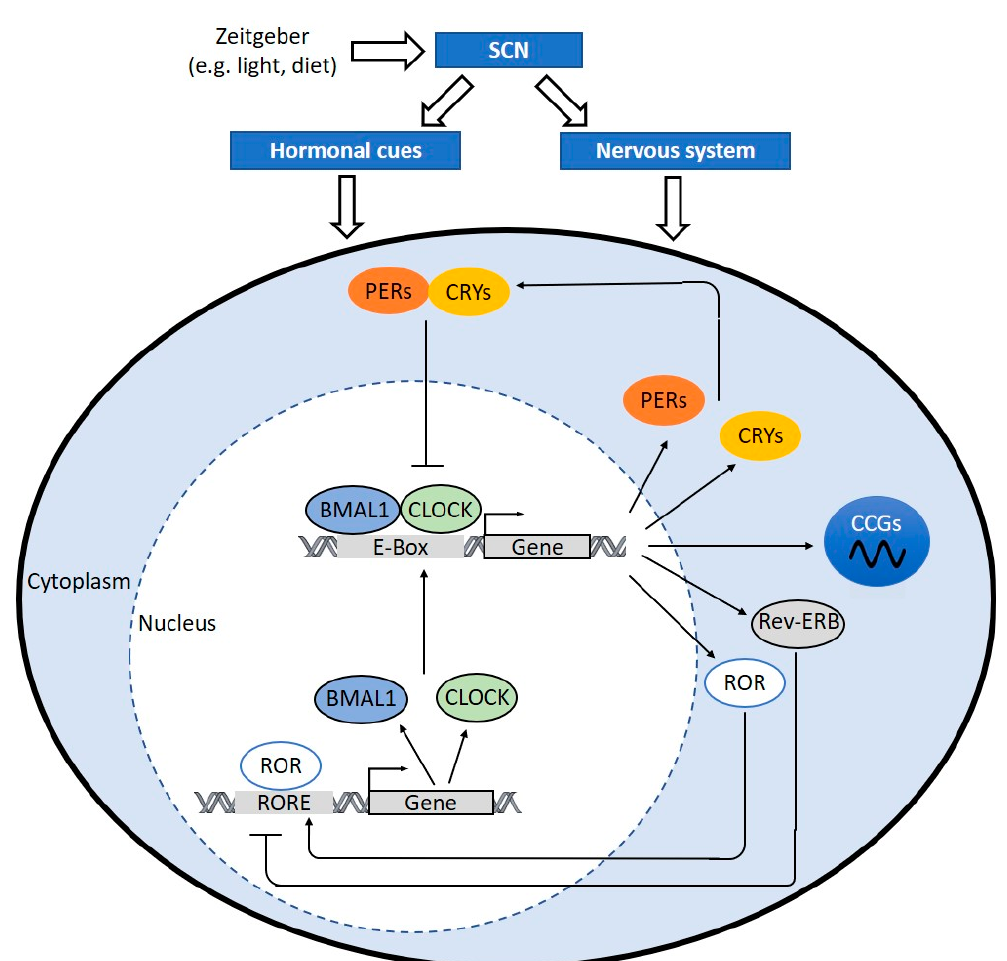
Figure 2. The molecular clock mechanism. When the hypothalamic suprachiasmatic nucleus (SCN) is triggered, the SCN translates signals into hormonal cues and nerve impulses, which can regulate the peripheral clock. In cells, the heterodimer of circadian locomotor output cycles kaput (CLOCK) and brain and muscle aryl hydrocarbon receptor nuclear translocator-like protein 1 (BMAL1) binds to E-box sequence (5 ′ -CACGTG-3 ′ ) in the promoter and activates the transcription of Period (PER)1/2/3, Cryptochrome (CRY)1/2, retinoic acid receptor-related orphan receptors (ROR), and reverse ERB (Rev-ERB). Dimerized PERs and CRYs translocate into nucleus and interfere CLOCK:BMAL1-mediated transcription. REV-ERB negatively regulates BMAL1 and CLOCK expression. RORs positively regulate BMAL and CLOCK expression via ROR response elements (RORE) at their promotor regions. The clock drives rhythmic expression of clock-controlled genes (CCGs) through CLOCK:BMAL1-mediated activation of circadian promoter elements, including E-boxes, D-boxes, and ROR response elements. CCGs encode important proteins involved in processes of atherosclerosis development, hemostasis, inflammation, lipid metabolism, and macrophage trafficking.